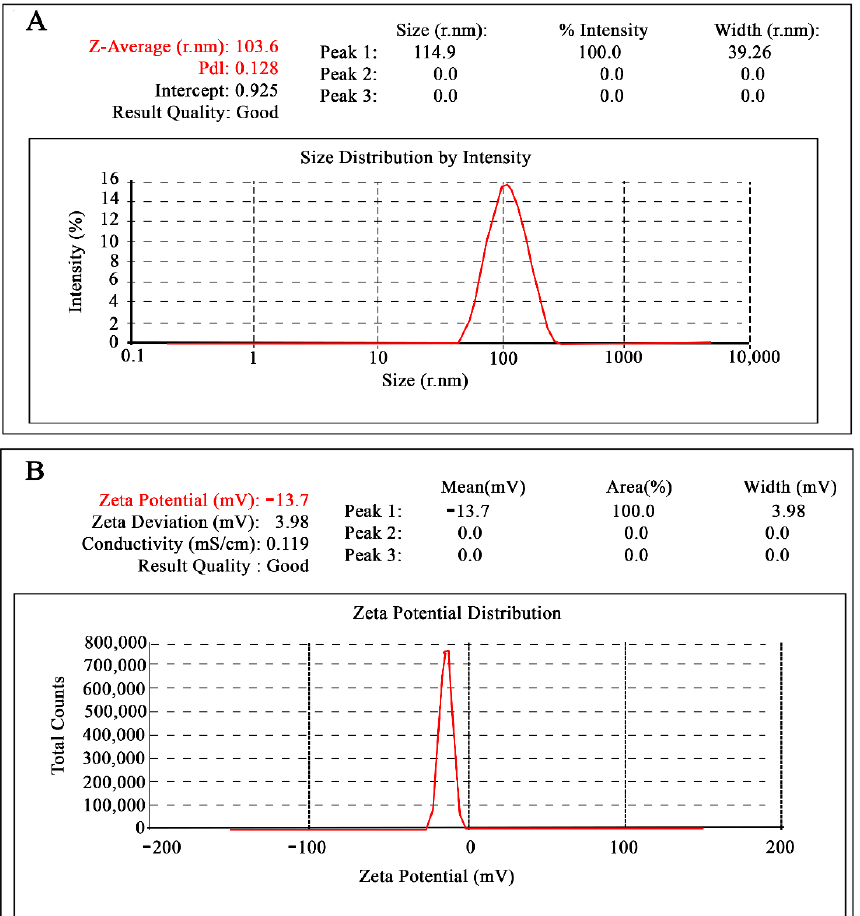
Figure 2. Graphical data showing particle size ( A ) and zeta potential ( B ) of the formulation for optimized APO-NPs.